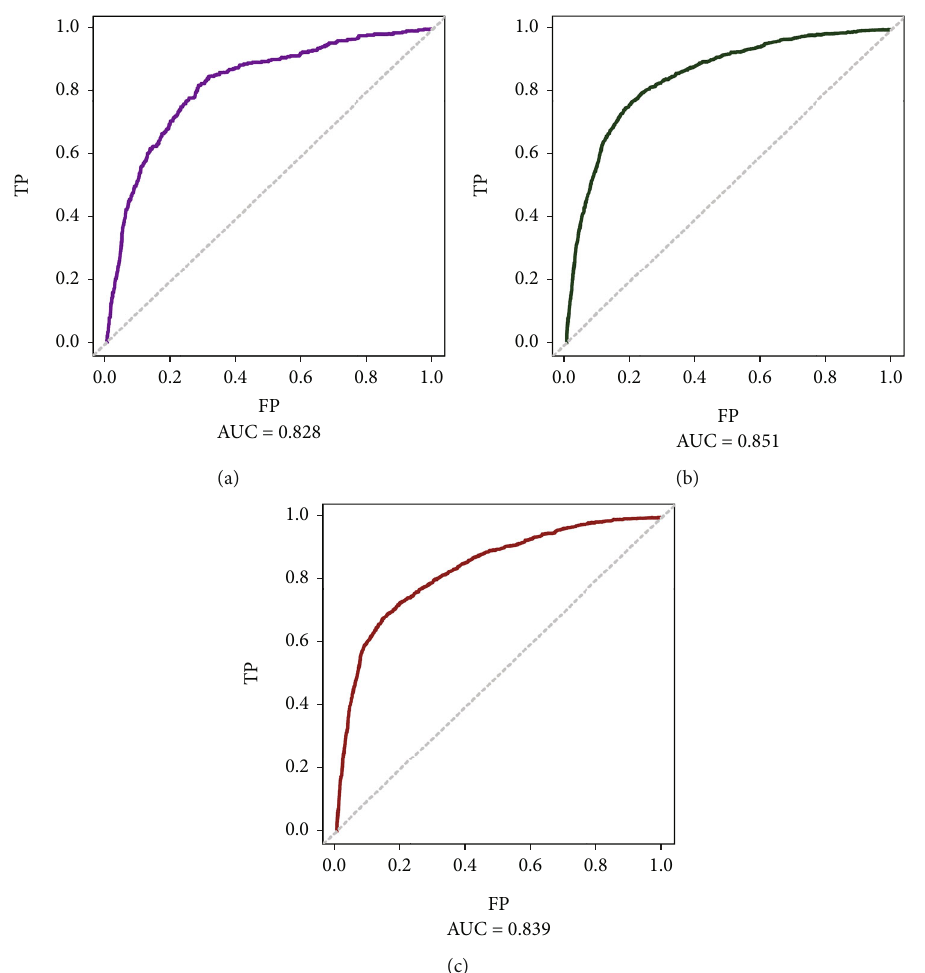
Figure 2: The ROC curves of the training dataset: (a) the mortality within one year; (b) the mortality within three years; (c) mortality within fi ve